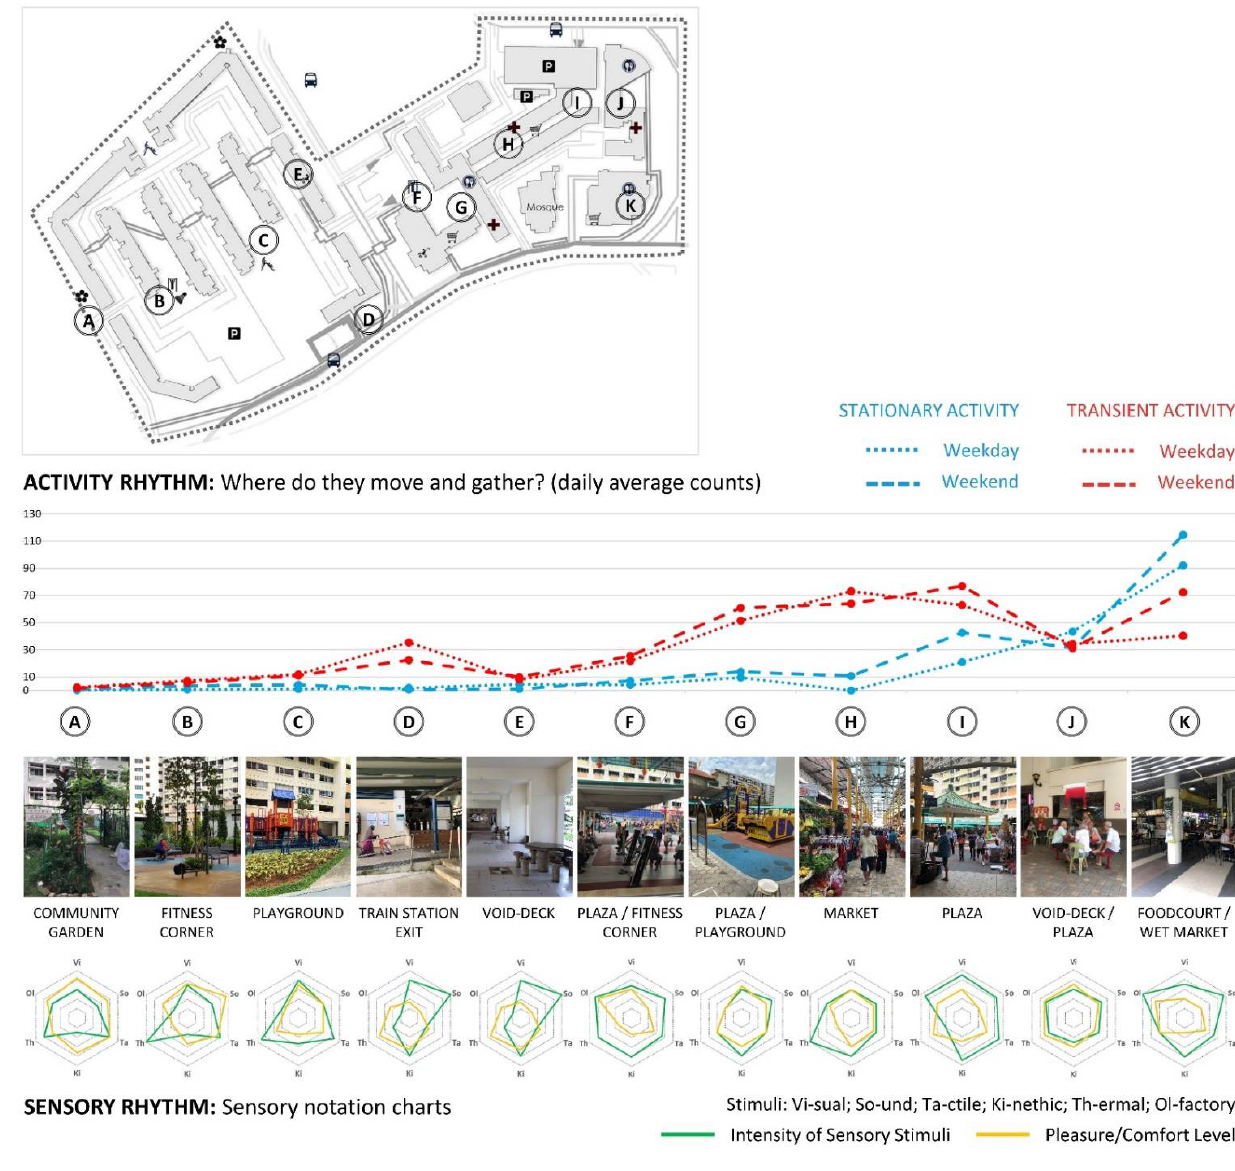
Figure 6. Summary of rhythm analysis in Bangkit neighbourhood (source: by author).